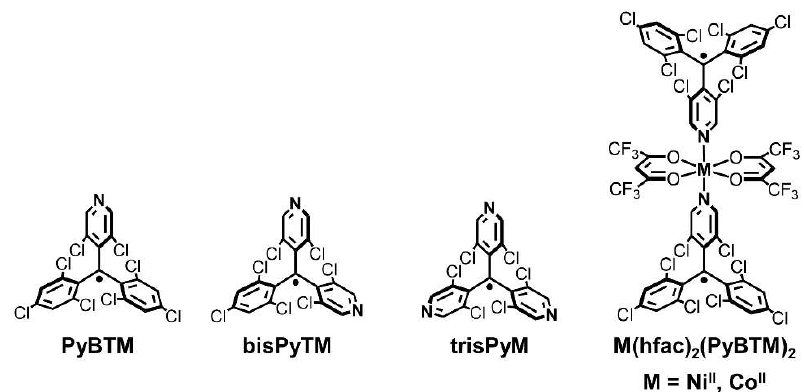
Figure 1. Chemical structures of radicals and [M(hfac) 2 (PyBTM) 2 ] (M = Ni II , Co II ).